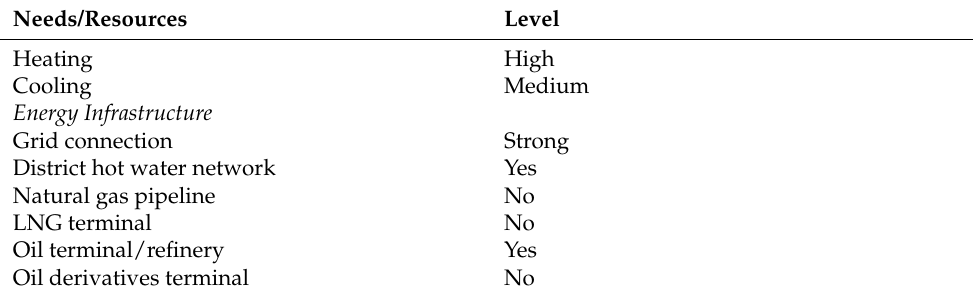
Table 3. RenewIslands questionnaire for the case of Kimmeria, Xanthi.